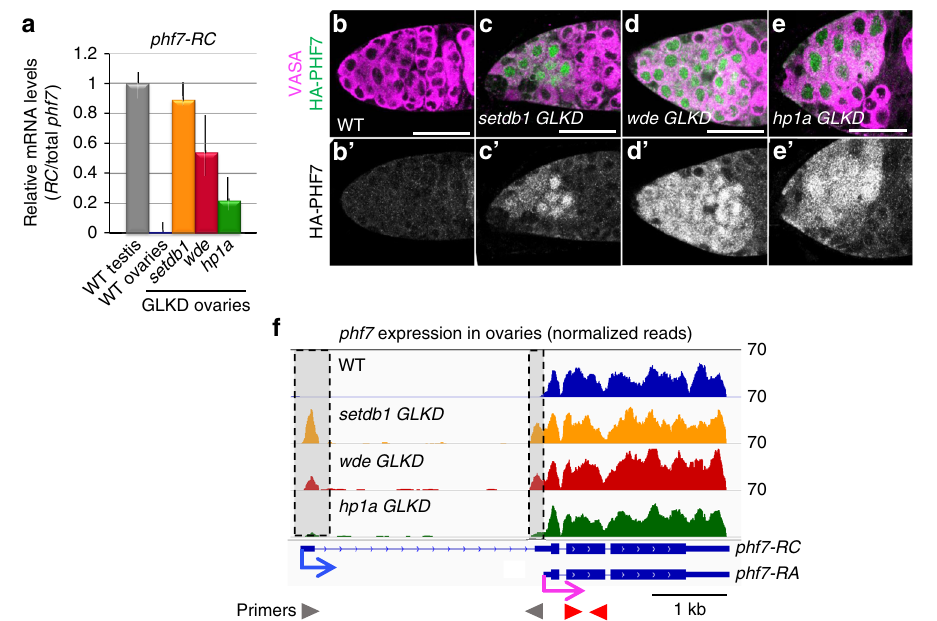
Fig. 2 SETDB1, WDE, and HP1a depletion leads to female-to-male reprogramming at phf7 . a Depletion of H3K9me3 pathway members leads to ectopic expression of the testis-speci fi c phf7-RC isoform. RT-qPCR analysis of the testis phf7-RC transcript in wild-type testis, wild-type and mutant ovaries. Expression, normalized to the total level of phf7 , is shown as fold change relative to testis. Primers are shown in panel F. Error bars indicate standard deviation (s.d.) of three biological replicates. b – e Depletion of H3K9me3 pathway members leads to ectopic expression of the testis-speci fi c PHF7 protein. Ovaries from animals carrying an HA-PHF7 transgene stained for HA (green, white in B ’ -E ’ ). Germ cells were identi fi ed by α -VASA staining (magenta). Scale bar, 25 μ m. f RNA-seq data con fi rms ectopic expression of the testis-speci fi c phf7-RC isoform. Genome browser view of the phf7 locus. Tracks show RNA-seq reads aligned to the Drosophila genome (UCSC dm6). All tracks are viewed at the same scale. The screen shot is reversed so that the 5 ’ end of the gene is on the left. The reads that are unique to the mutant ovaries are highlighted in gray. The two phf7 transcripts, phf7-RA and phf7-RC , are indicated. phf7-RC is normally only expressed in testis (blue arrow). phf7-RA is normally expressed in ovaries (pink arrow). Primers for RT-qPCR are indicated by arrowheads: gray for phf7-RC , red for total